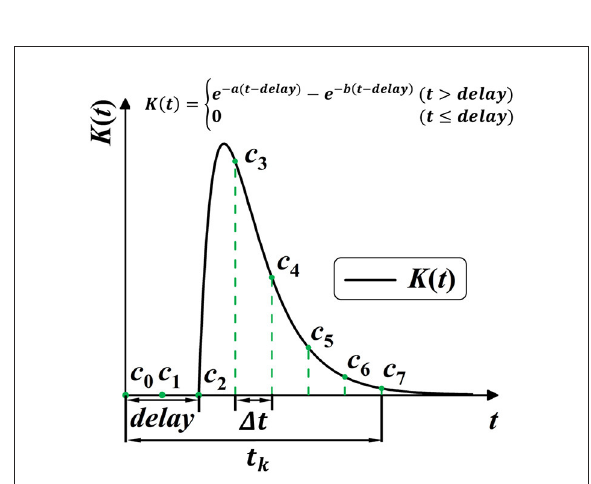
FIGURE5 Model the SRM K ( t ) into 1-D convolution kernel C n . K ( t ) is modeled with three trainable parameters, with a , b for shape, and delay for the time